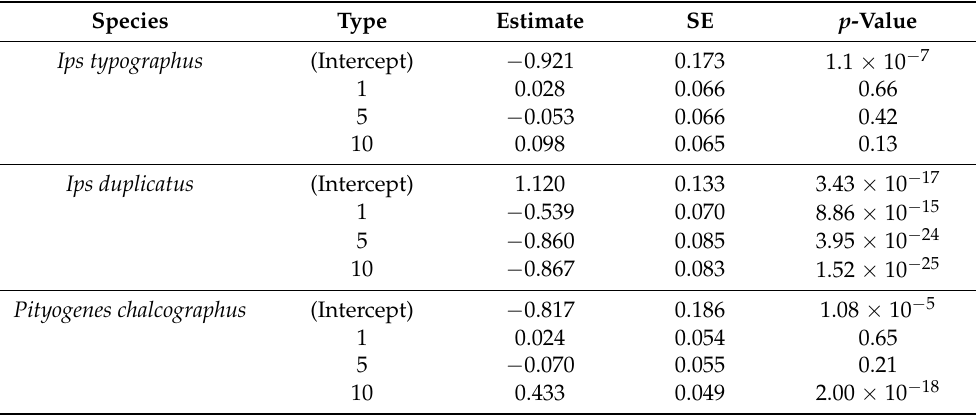
Table 2. Relationships between the number of nuptial chambers and plot, type of trees (distance from lure tree), and the height of the position of strip on the trap tree as indicated by the general linear model log (numbers of nuptial chambers) = 1 + plot + type + height. The coefficient estimates are accompanied with the standard error of estimate (SE) and the p -values.